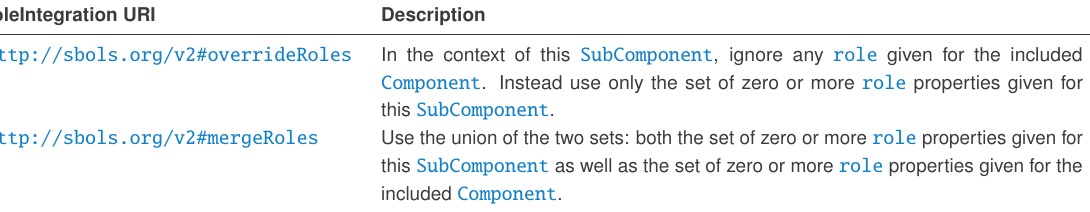
Table 6: Each roleIntegration mode is associated with a rule governing how a SubComponent ’s role values are to be combined with the included Component ’s role